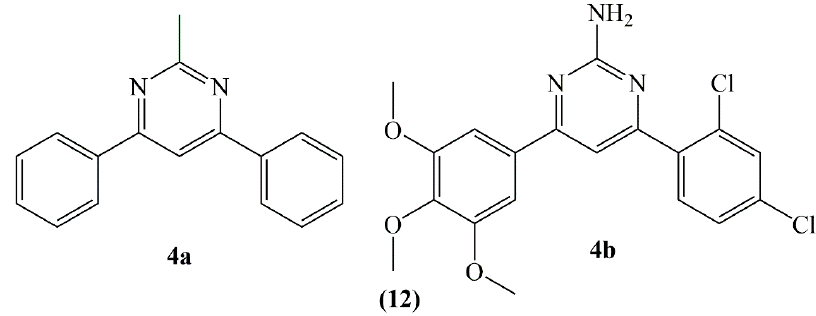
Figure 4. Structure of diphenyl pyrimidine analogues 4a and 4b .